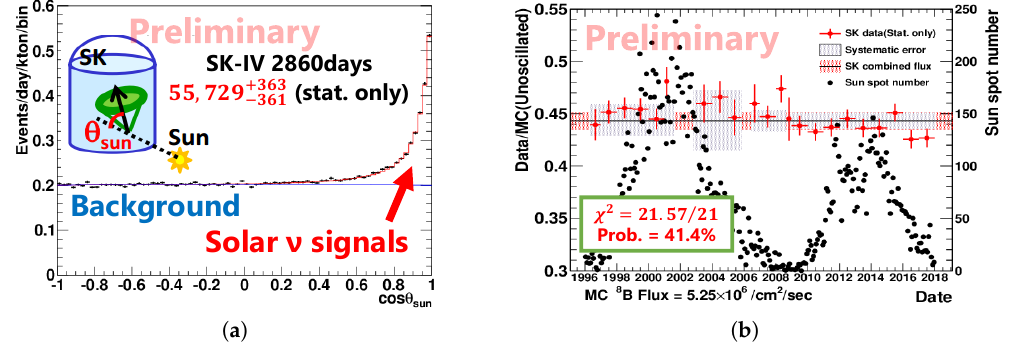
Figure 4. ( a ) Distribution of cosine between the direction of the Sun and the reconstructed direction of recoil electrons. ( b ) Solar neutrino event rates relative to the prediction [75] as a function of the time (red points) together with the number of sunspots (black points)